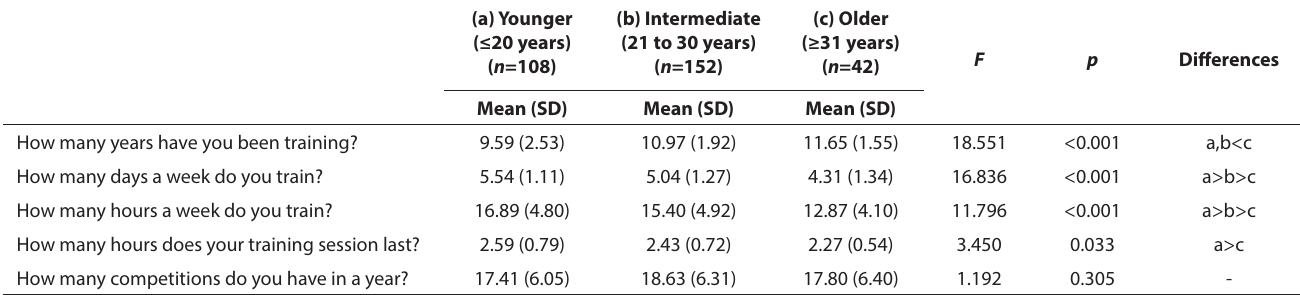
TABLE 2 Means and standard deviations of responses to training volume questions, and one-way ANOVA with Bonferroni post hoc test as a function of